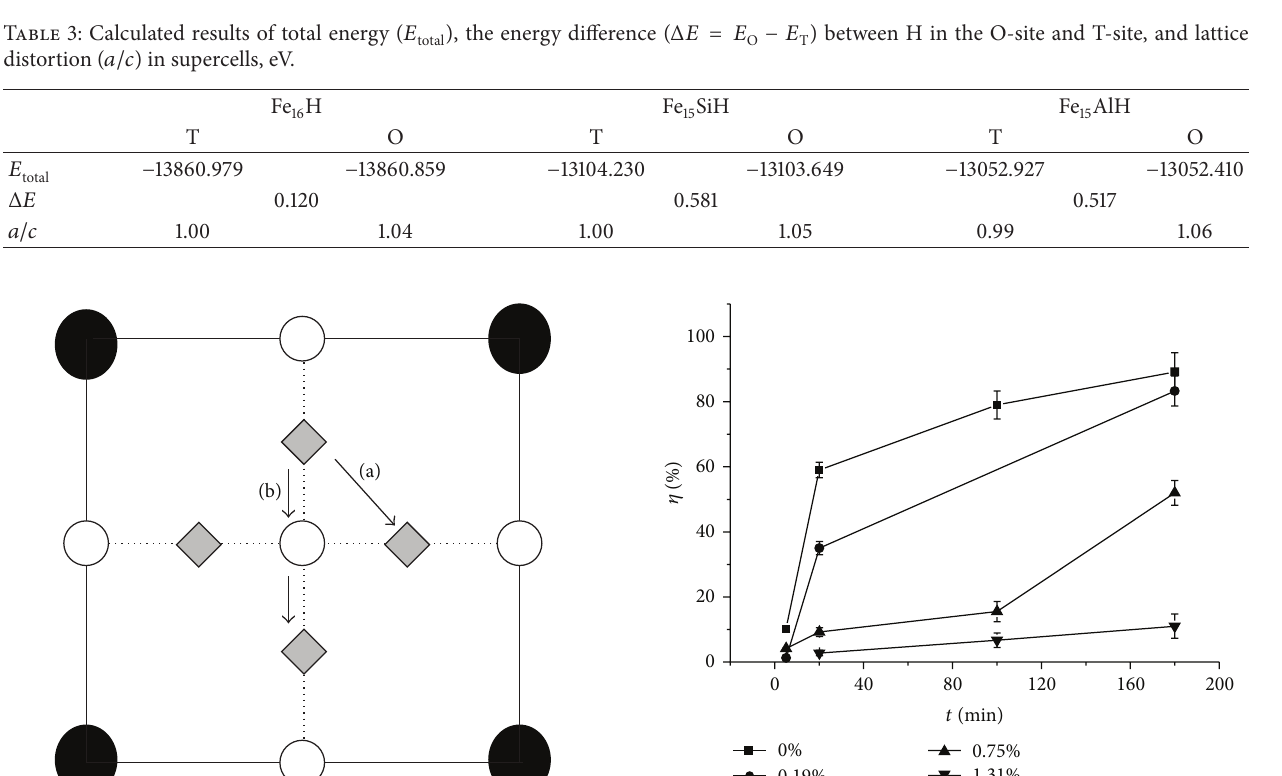
), the energy difference ( Δ𝐸 = 𝐸 total